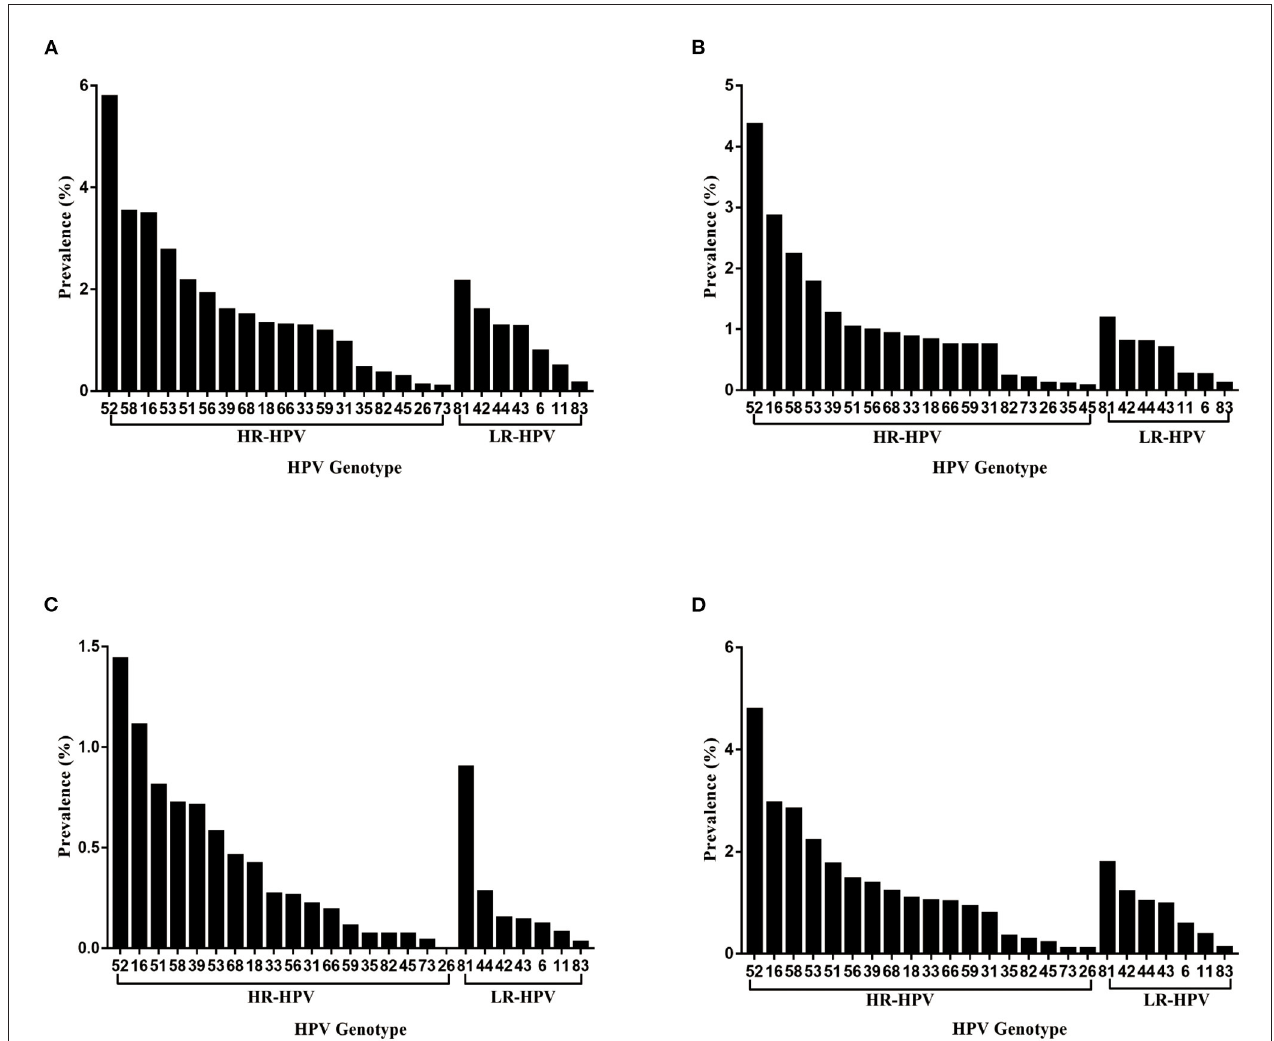
FIGURE 2 | (A–D) Distribution of HPV genotypes among gynecological outpatients (A) , reproductive gynecological outpatients (B) , physically examined population (C) , total HPV-positive cases (D) .